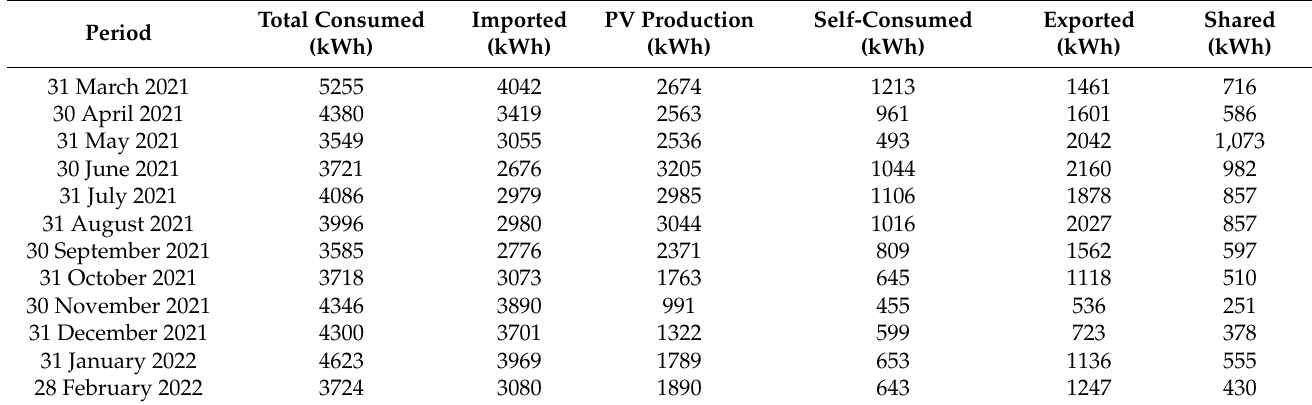
Table 6. Energetic quantities for each month under consideration.